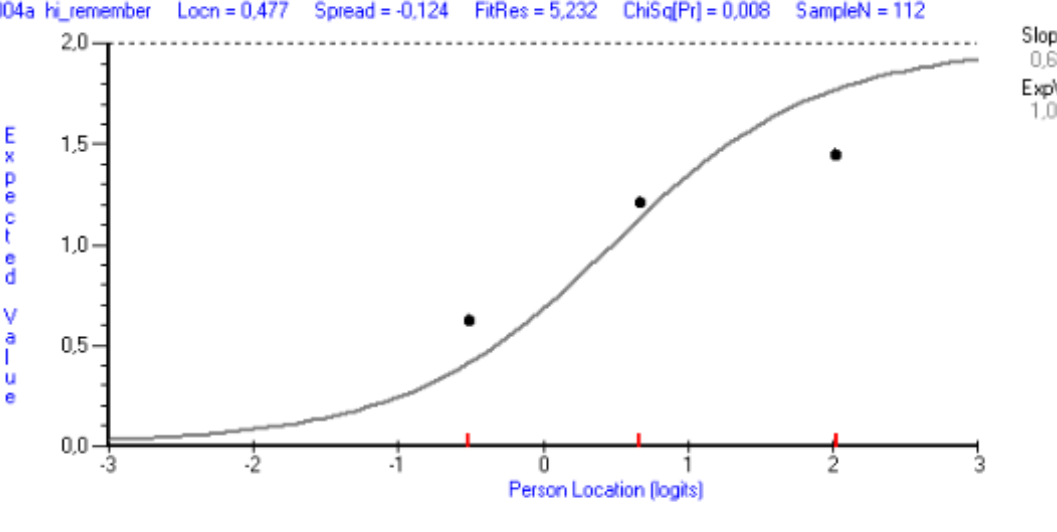
Figure 2. Item characteristic curve (ICC) showing a line with the expected response (predicted from the model) and the dots corresponding to the observed response. The illustration shows how the dots deviated from the ICC for the item It has been difficult to remember to use